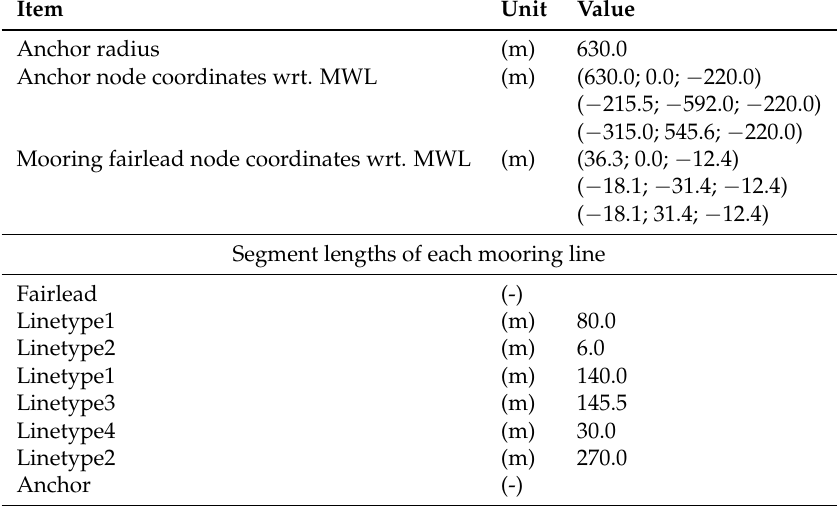
Table 8. Mooring system description.